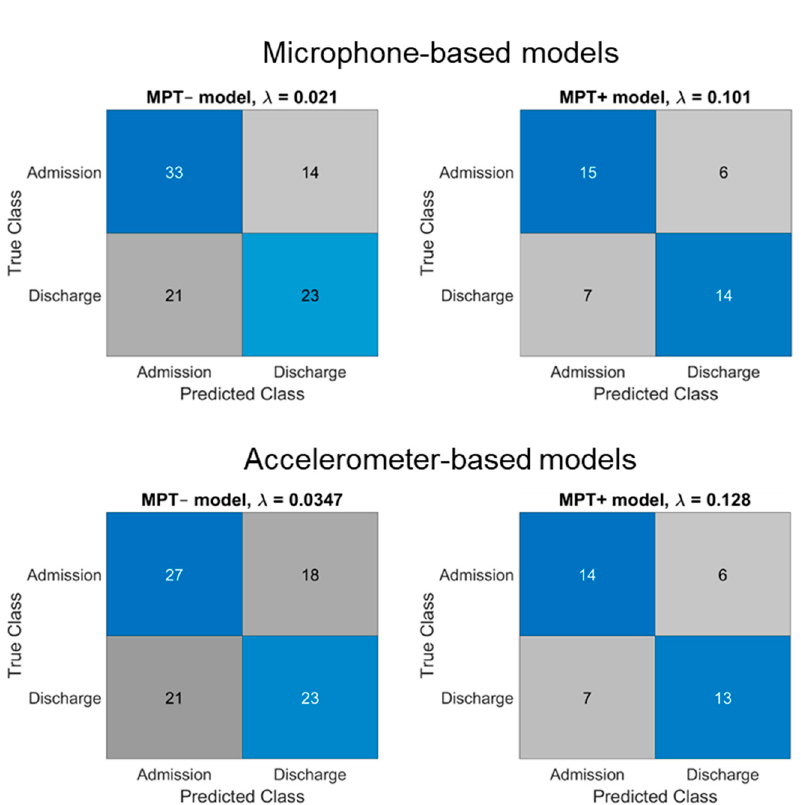
Figure 2. Confusion matrices and optimized lambda values ( λ ) for the microphone-based and accelerometer-based models without (MPT − ) and with (MPT+) the maximum phonation task.